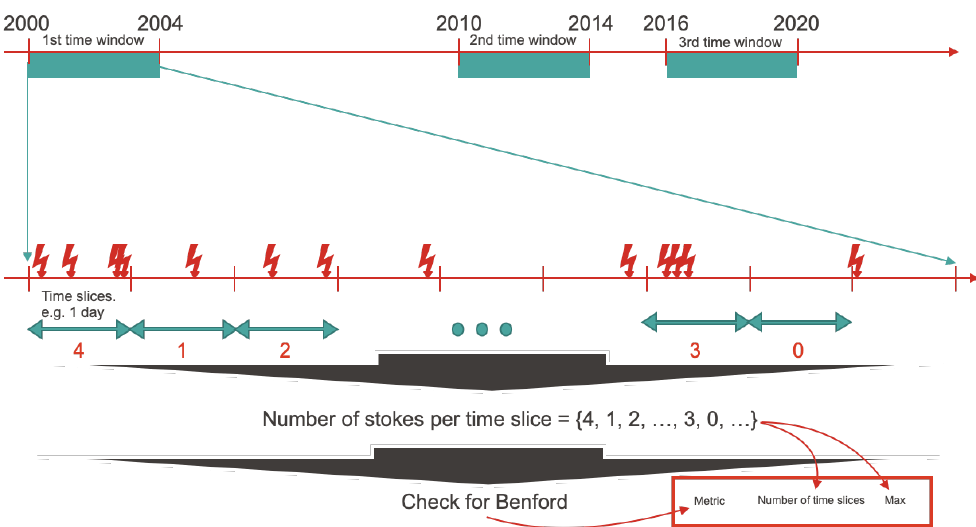
Figure 3. Data preprocessing: Each time window is divided into time slices and the number of strokes detected by the LLS within each slice constitutes a data